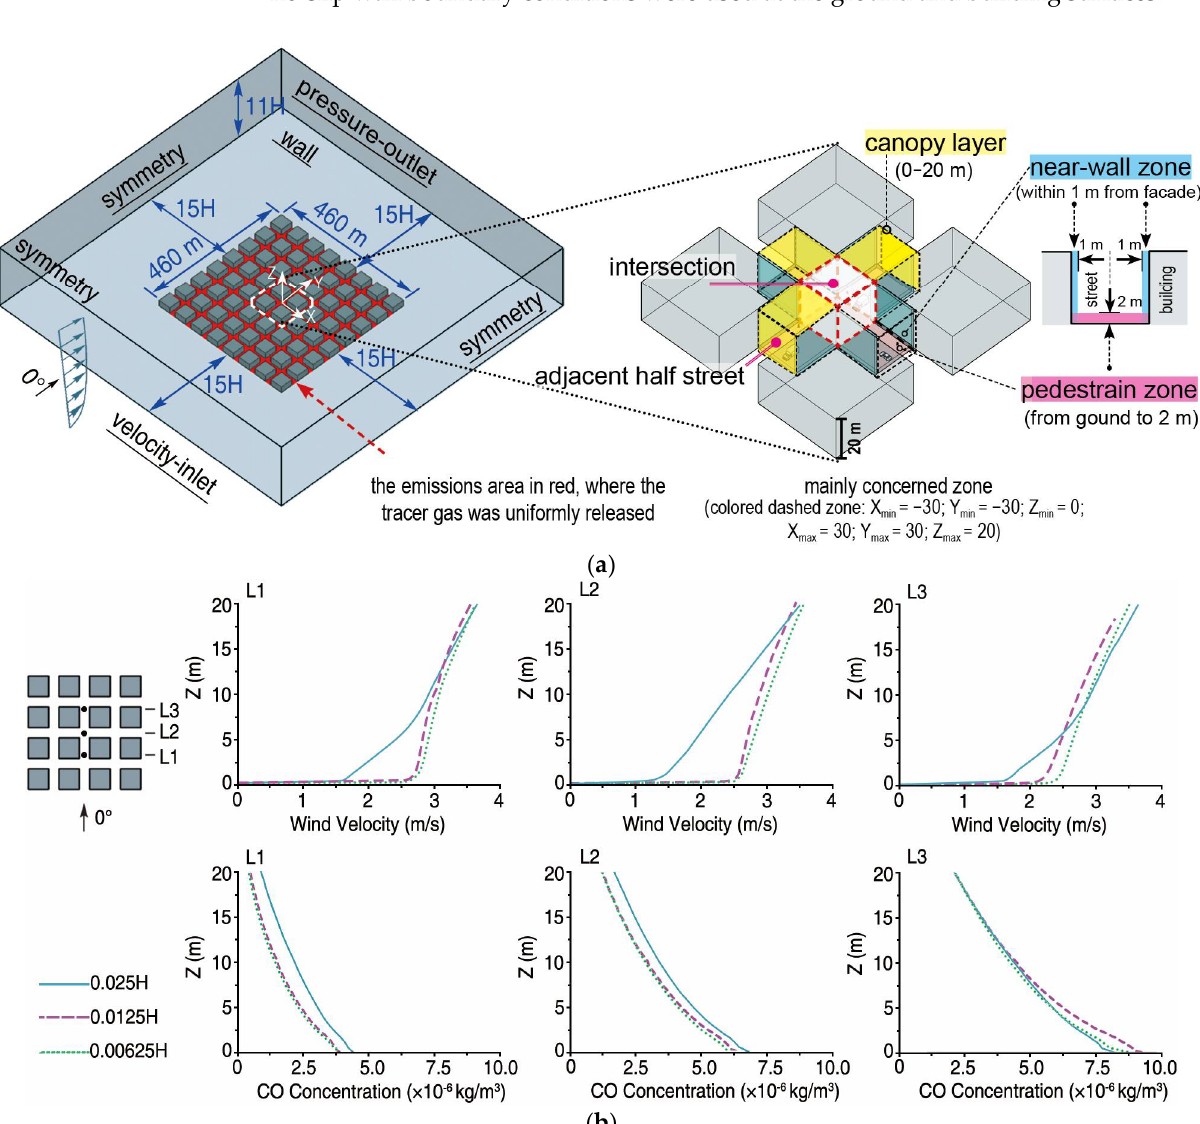
Figure 3. Case A-0 taken as an example. ( a ) Computational domain and boundary conditions used in CFD simulations and ( b ) grid sensitivity study.